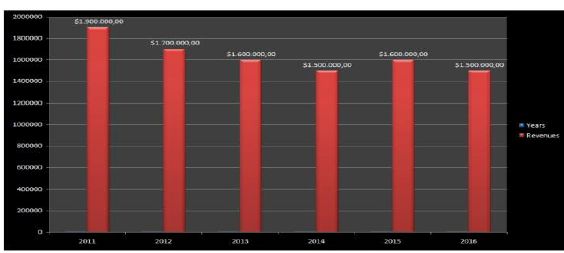
Table 3: CORS-TR System Revenue between 2011 and 2016